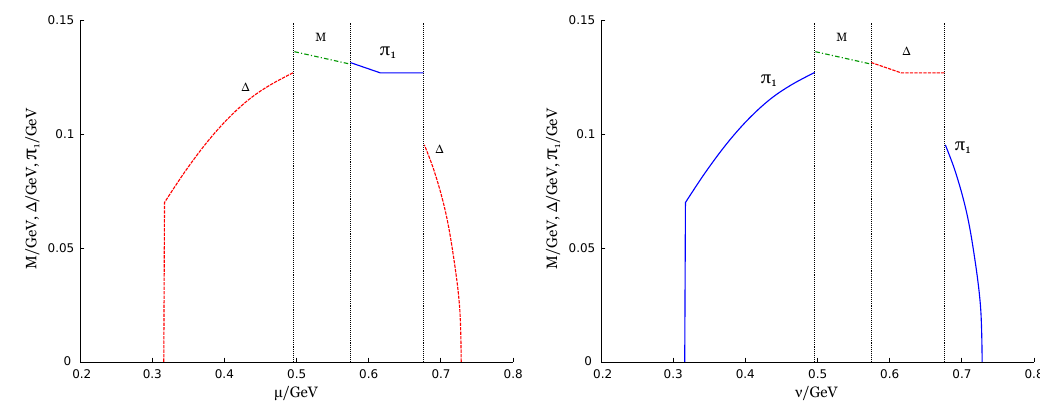
Figure 5 . Left panel: the gaps M (dash-dotted line), (cid:25) 1 (solid line) and j (cid:1) j (dashed line) as a function of (cid:22) at (cid:23) = 0 : 57 GeV and (cid:23) 5 = 0 : 6 GeV. Right panel: the gaps M , (cid:25) 1 and j (cid:1) j as a function of (cid:23) at (cid:22) = 0 : 57 GeV and (cid:23) 5 = 0 : 6 GeV. Other notations are the same as in (cid:12)gure